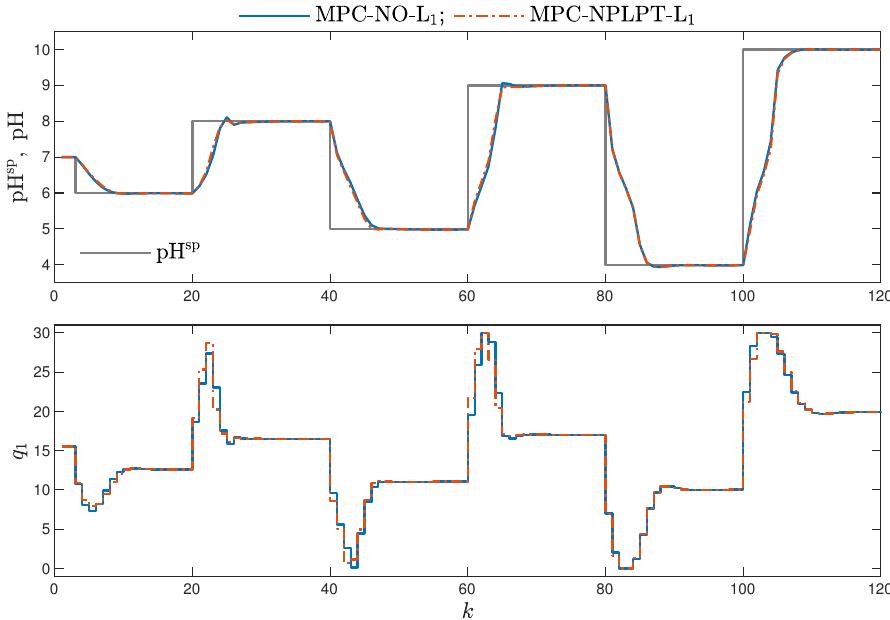
Figure 7. Simulation results: the MPC-NO-L 1 algorithm vs. MPC-NPLPT-L 1 algorithm.